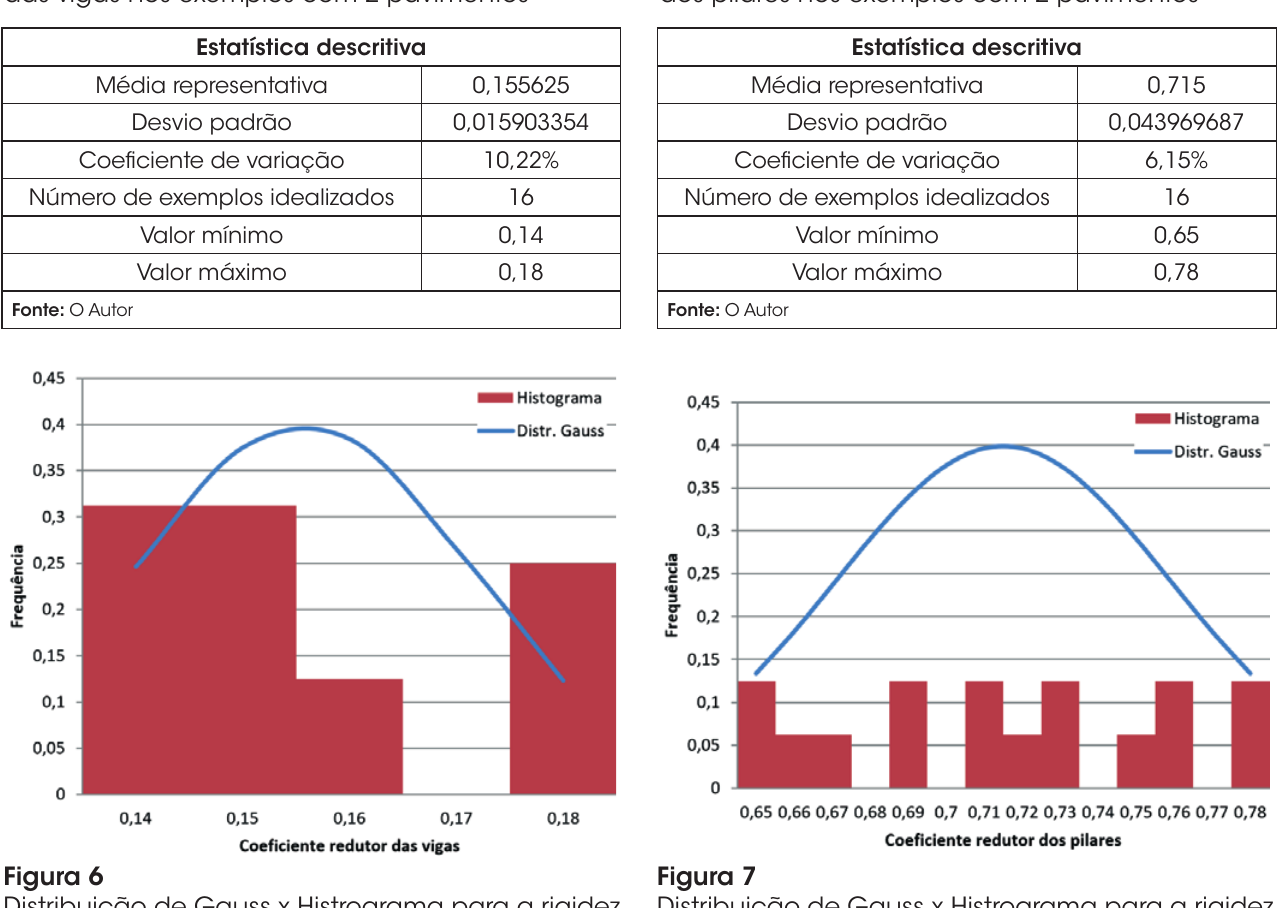
Distribuição de Gauss x Histrograma para a rigidez das vigas nos exemplos com 2 pavimentos